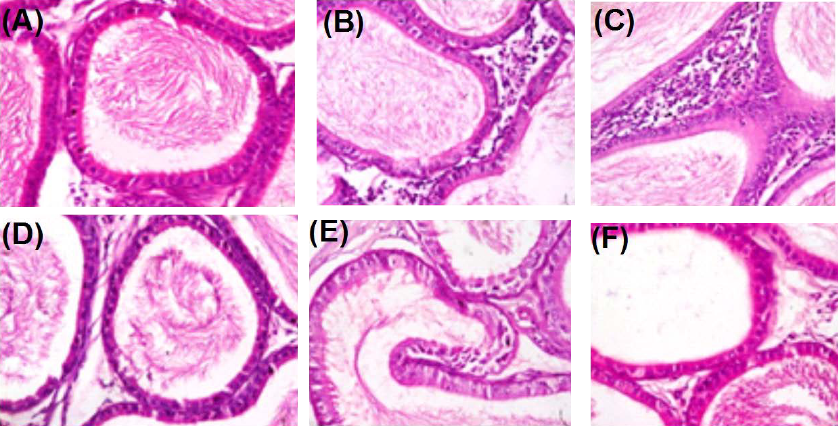
Figure 9: Photomicrograph of epididymis after exposure of rats to Ag-NPs showing ( A ) epididymal ducts with normal smooth muscle layer and epithelial layers, stored content of spermatozoa within the lumen; ( B ) interstitial spaces with moderately increased interstitial connective tissues; ( C ) mildly increased fibrotic tissues, interstitial spaces with severe infiltration of connective tissues and inflammatory cells; ( D ) normal smooth muscle layer and epithelial layers; ( E ) interstitial spaces with moderate infiltration of inflammatory cells and interstitial congestion; ( F ) interstitial congestion with ducts having empty lumen lacking spermatozoa. Magnification 400×. A: Control, B: 10 mg/kg bw, C: 50 mg/kg bw, D: Control, E: 10 mg/kg bw, F: 50 mg/kg bw. A–C (7 days exposure of Ag-NP), D–F (28 days exposure of Ag-NPs).